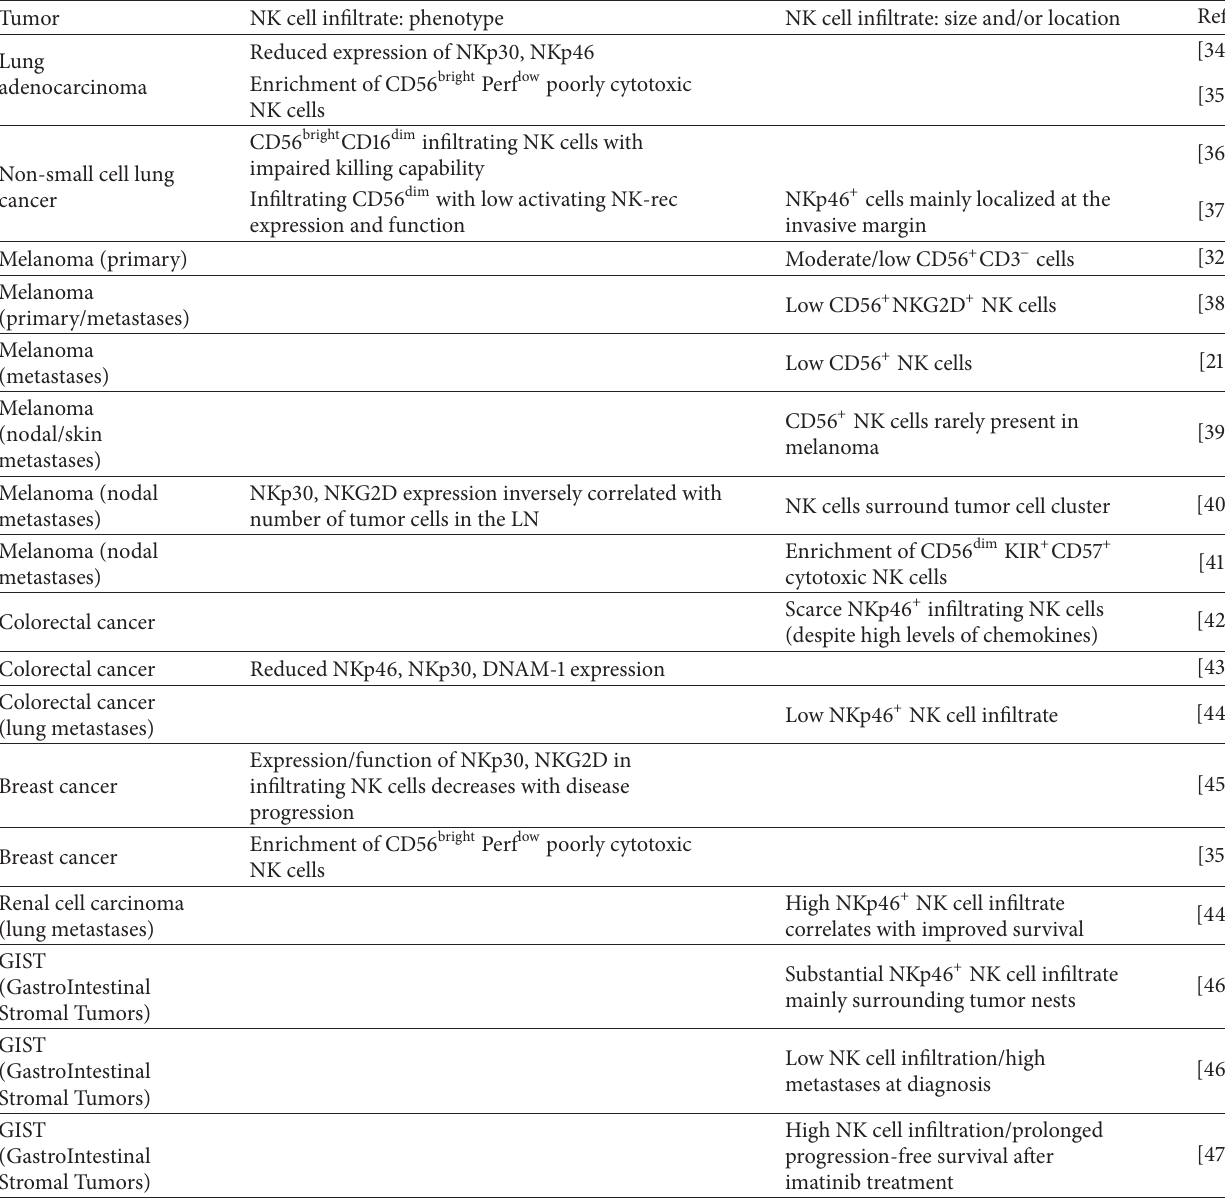
Table 1: NK cell infiltrate in solid